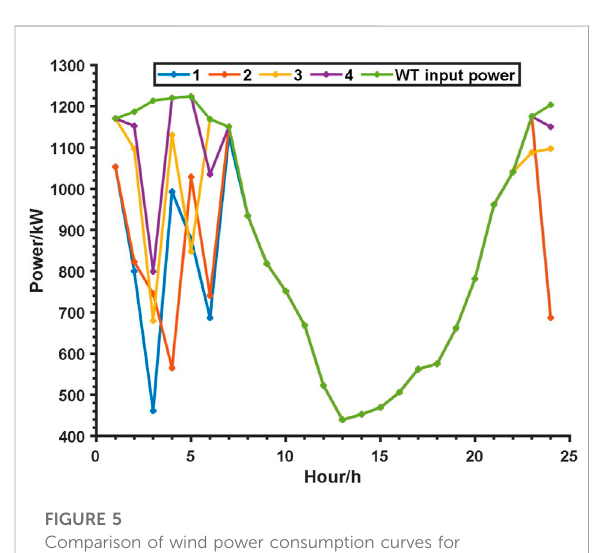
FIGURE 5 Comparison of wind power consumption curves for scenarios 1, 2, 3, and 4.